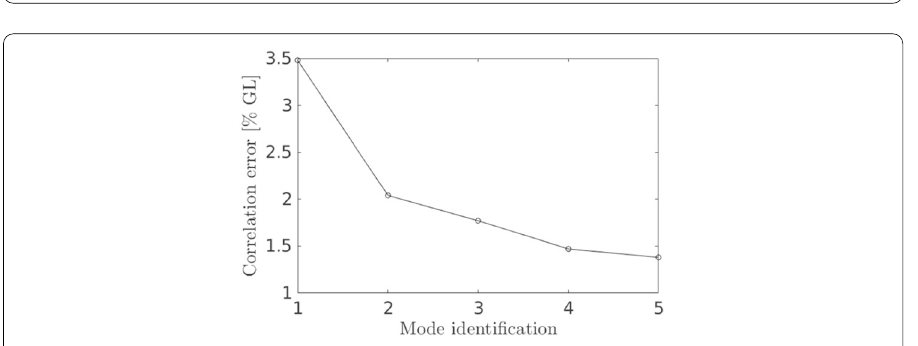
Fig. 6 Residual fields projected at 6 π/ 5 ( a ) before kinematics correction and ( d ) after the 5 mode identification. The dashed line corresponds to the envelop of the mesh projection and defines the region of interest. The residual on the top left part corresponds to large motion that may not be correctly captured with the boxed mesh